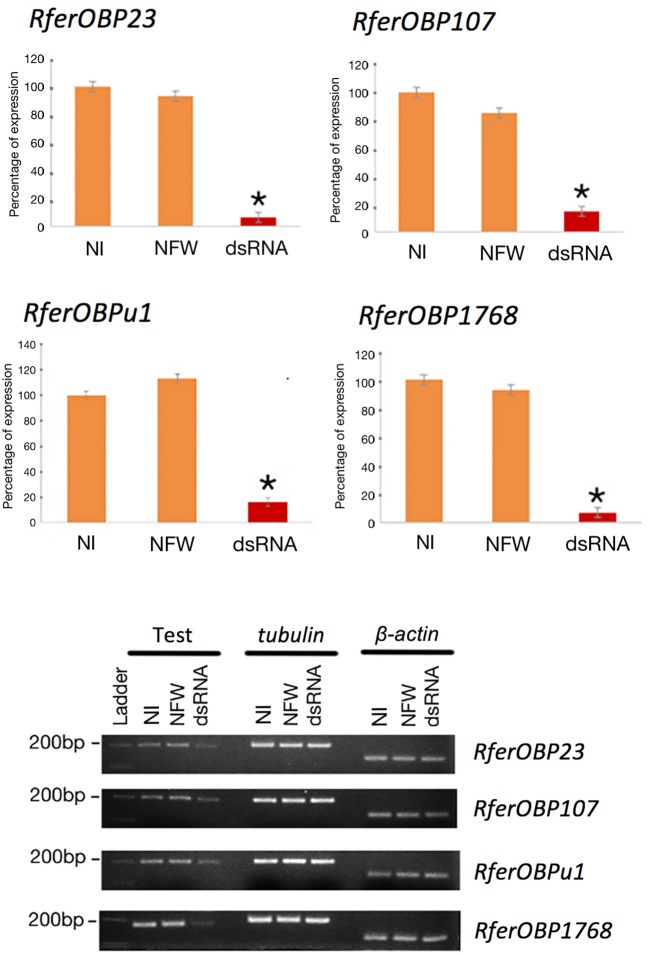
RNAi-based gene silencing of candidate RferOBPs validated by qRT-PCR. Error bars represent the SEM. Significance was measured using one-way ANOVA with respect to the control. *A significant reduction in gene expression (P < 0.001). Representative visual bands of 1. NI (control), 2. NFW, and 3. dsRNA-injected groups. The first row shows expression of RferOBPs in the different experimental groups, and the second and third rows show tubulin and β-actin expression (refer Table S1) in the different experimental groups.